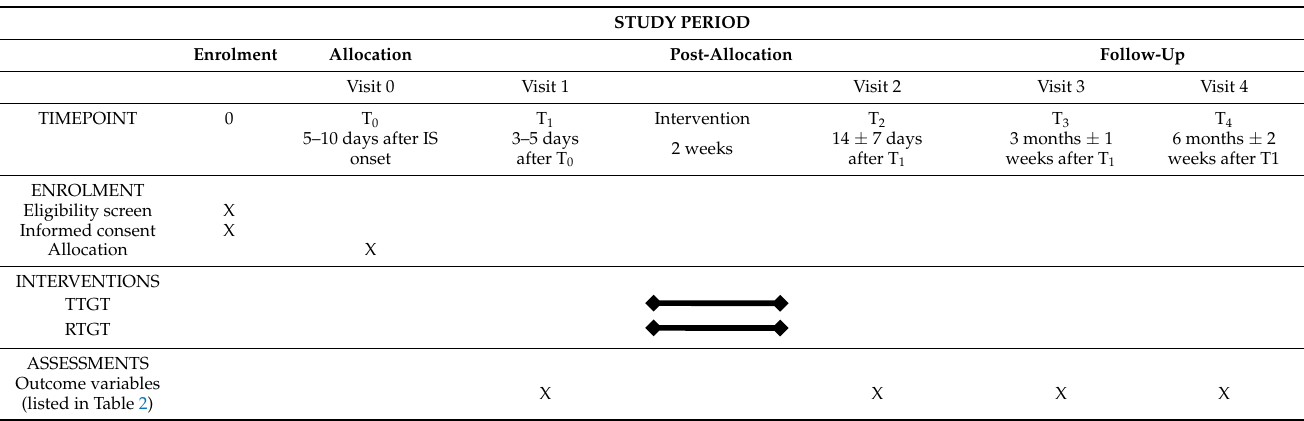
Table 1. Schedule of enrolment, interventions, and assessments at each time point (T0–T4) according to Recommendations for Interventional Trials